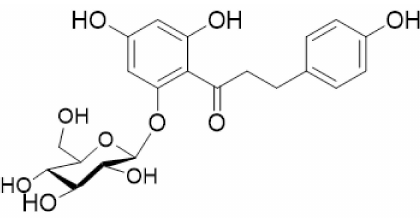
Figure 1. The structure of